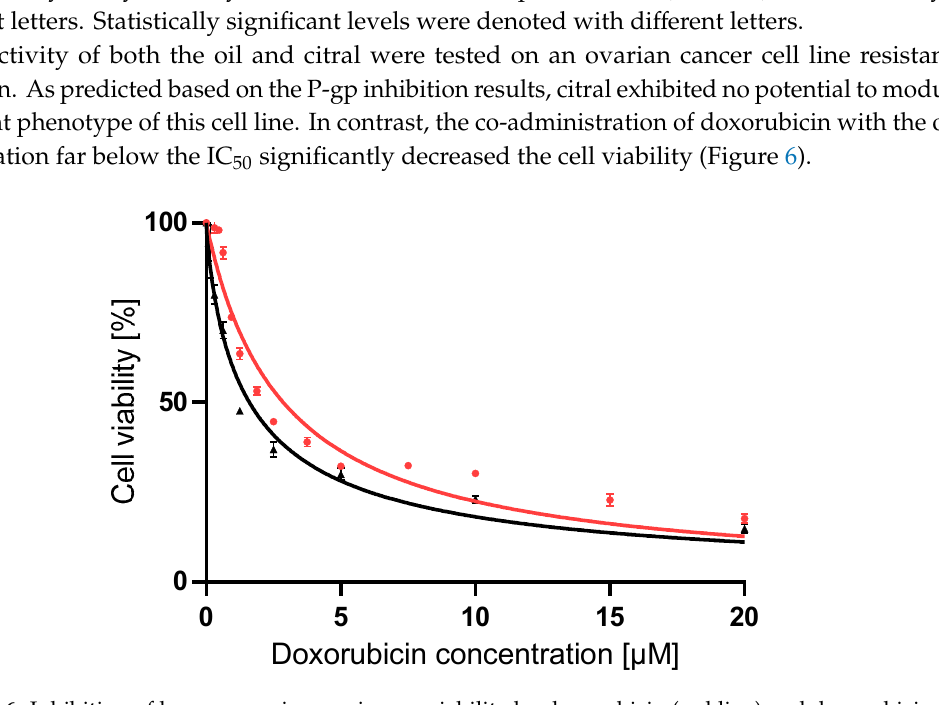
Figure 6. Inhibition of human ovarian carcinoma viability by doxorubicin (red line) and doxorubicin with lemongrass essential oil (10 µL/L, black line) after 72 h.